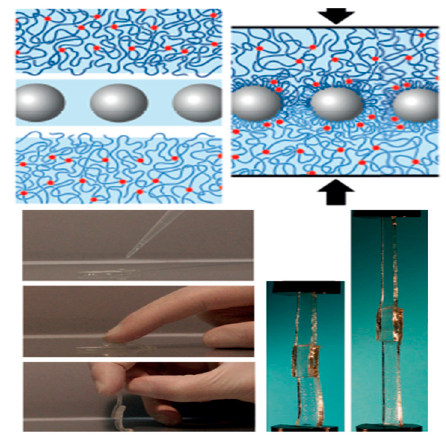
Figure 4. Schematic illustration of the concept of gluing swollen polymer networks together using silica NPs, reproduced with permission from [81]. Copyright Nature Publishing Group,